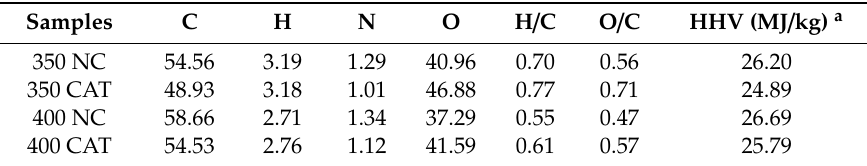
Table 4. Elemental composition (daf), HHVs, and atomic ratios of solid